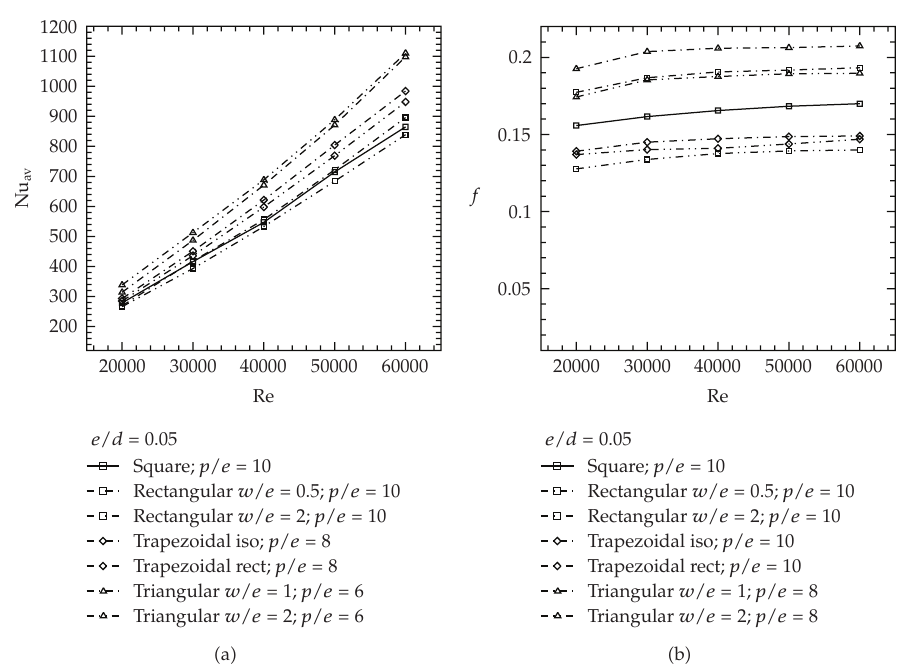
Figure 10: Profiles as a function of Reynolds numbers in the range 20000–60000 at e/d (cid:8) 0 . 05 for di ff erent rib shapes and significant pitches: (cid:6) a (cid:7) average Nusselt number and (cid:6) b (cid:7) friction